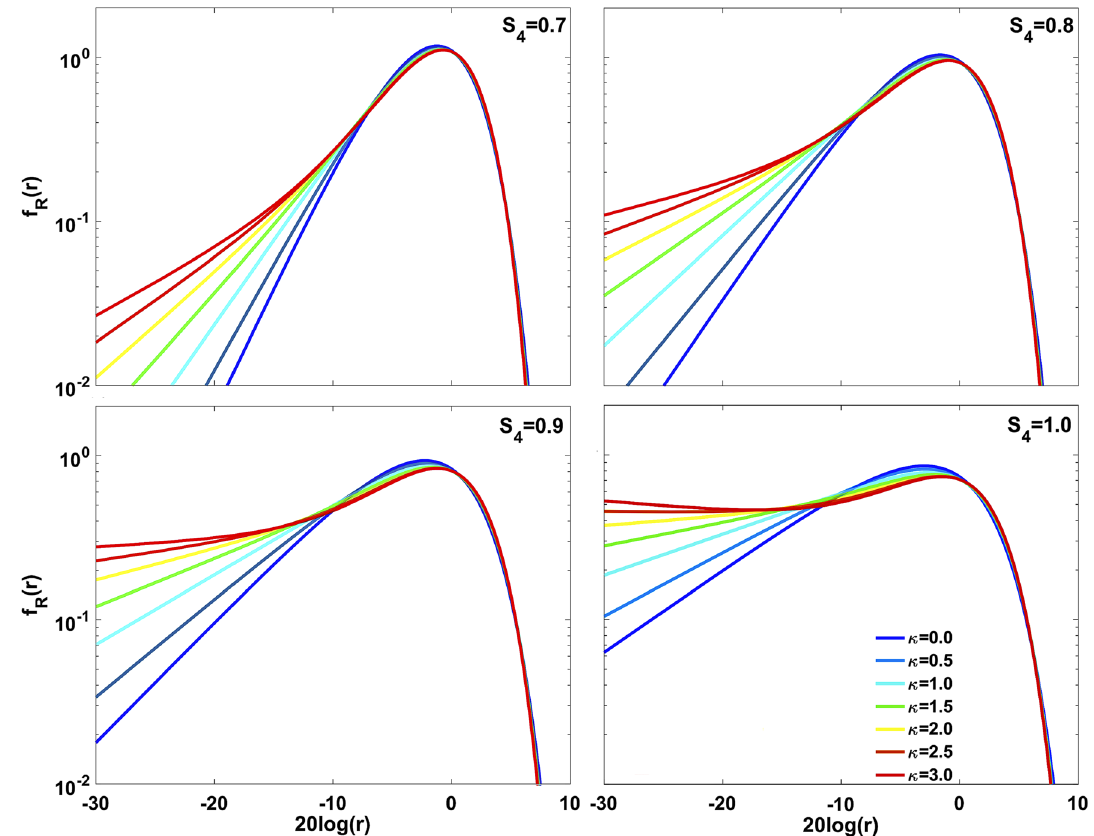
Fig. 7. Various shapes of j - l density function for different values of S 4